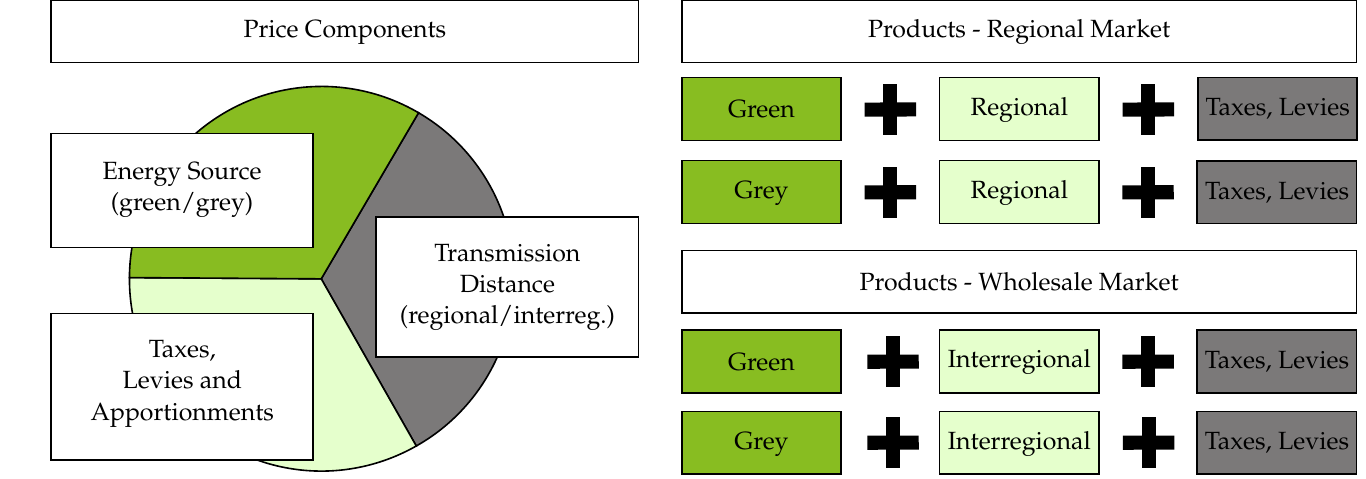
Figure 3. Price components and electricity